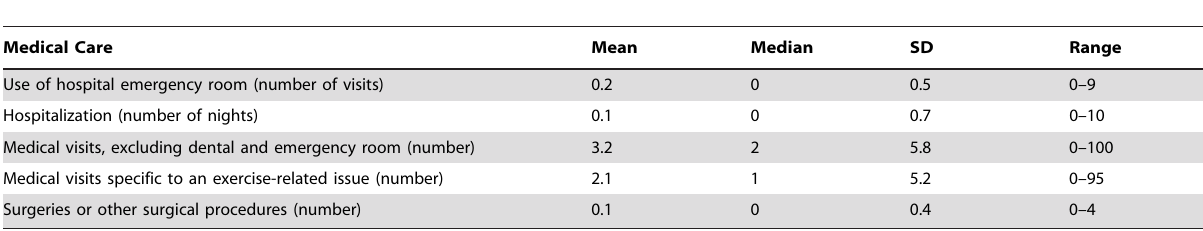
Table 3. Use of the medical care system during the prior 12 months among 1,212 active ultramarathon runners.